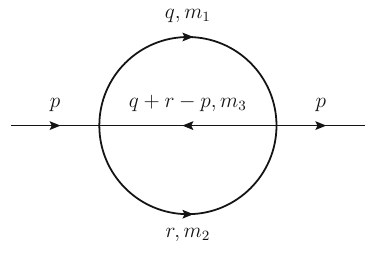
Fig. 1 The sunset diagram